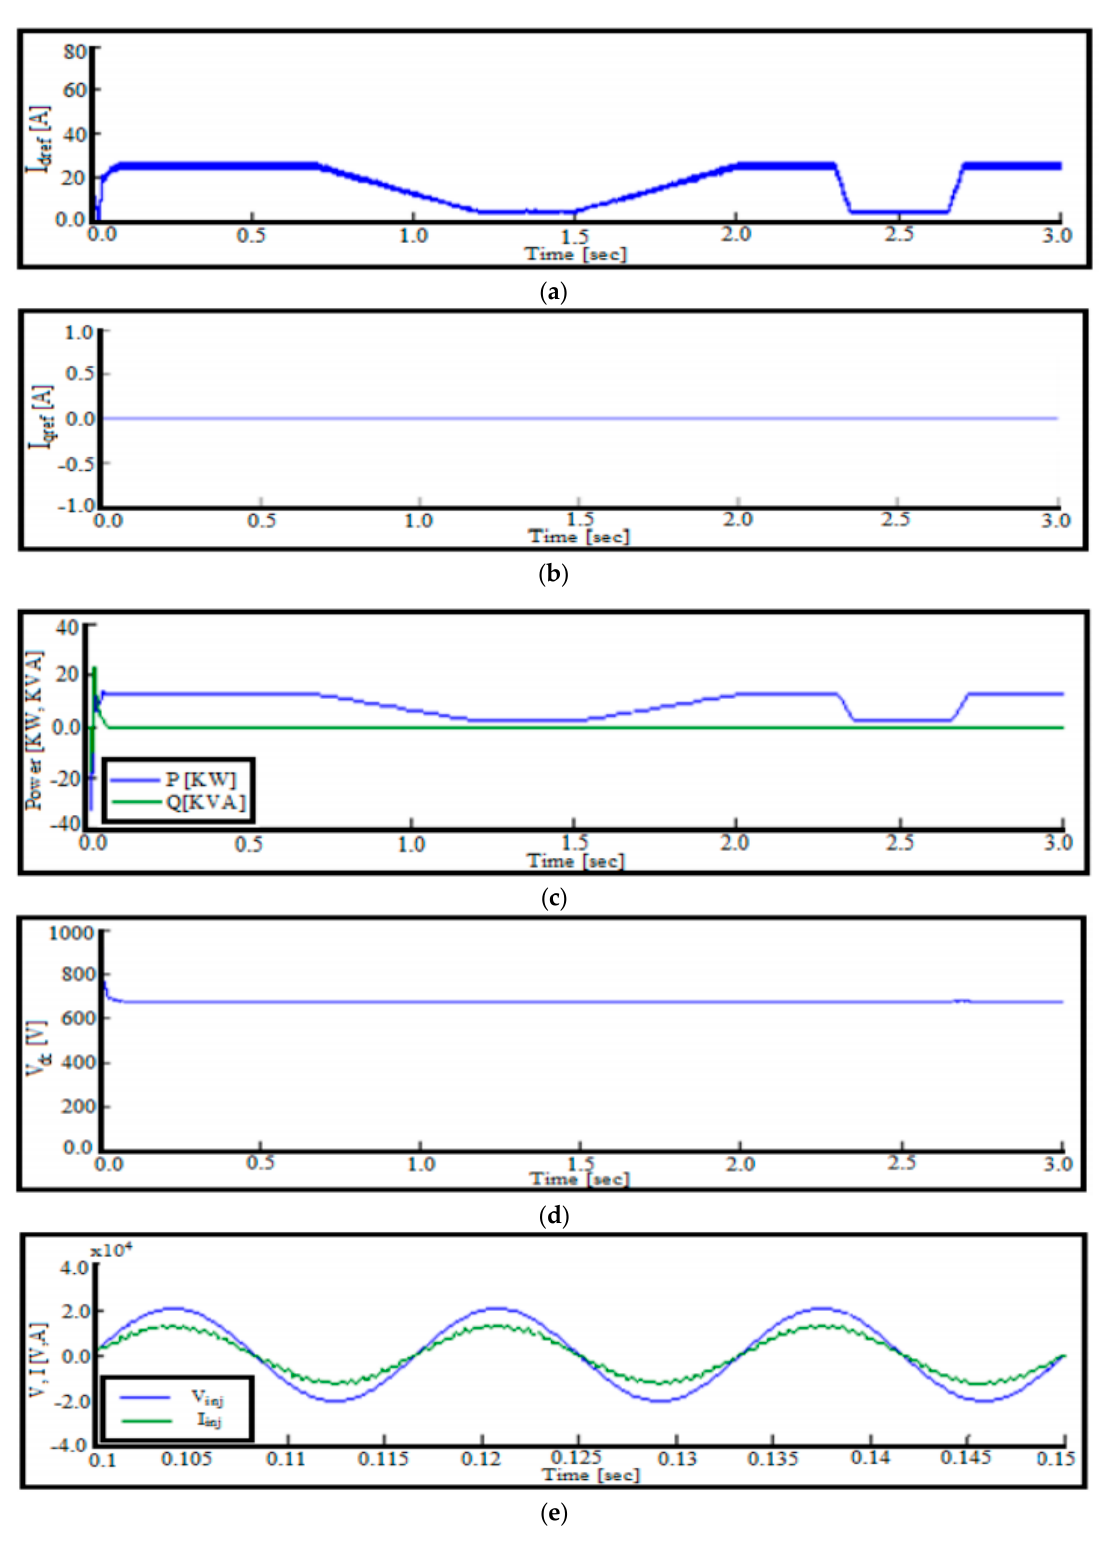
Figure 26. ( a ) I dreq vs. Time of P&O at Grid Side; ( b ) I qref vs. Time of P&O at Grid Side; ( c ) Power in KW and KVA vs. Time of P&O at Grid Side; ( d ) V dc vs. Time of P&O at Grid Side; ( e ) Current and voltage injected to the grid of P&O at Grid Side.